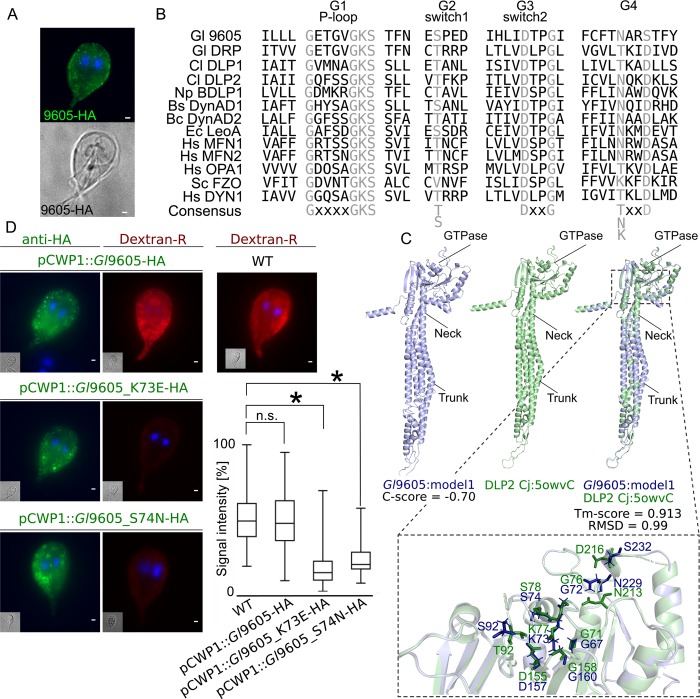
The extended GlPXD3 interactome includes a novel dynamin-like protein in G. lamblia.(A) Light-microscopy-based immunofluorescence analysis of representative transgenic trophozoites expressing epitope-tagged reporter variants (green) for protein Gl9605. Cells were imaged at maximum width, where nuclei and the bare-zone are at maximum diameter. Nuclei are labelled with DAPI (blue). Scale bar: 1 μm (B) MSA analysis G1-P-loop, G2 switch 1, G3 switch 2 and G4 regions of the conserved GTPase domains of Gl9605, GlDRP, Campylobacter jejuni DLP1 (Uniprot accession CJ0411) and DLP2 (CJ0412), Nostoc punctiforme BDLP1 (B2IZD3), Bacillus subtilis DynAD1 (P54159), Bacillus cereus DynAD2 (CUB17917), and Escherichia coli LeoA (E3PN25) bacterial dynamin-like proteins (BDLPs), Homo sapiens MFN1 (Q8IWA4), MFN2 (O95140), OPA1 (O60313) and DYN1 (Q05193), and Saccharomyces cerevisiae Fzo1p (P38297). Conserved positions are highlighted in grey. (C) I-TASSER de novo predicted 3D structure for Gl9605 (blue) and its closest known structural homologue, C. jejuni DLP2 (5owvC; green) indicating the GTPAse, neck and trunk regions that characterize BDLPs. A close-up view of the overlapping structures in the GTPase domains of Gl9605 (blue) and C. jejuni DLP2 (5owvC; green) marked with specific residues important for GTP binding and catalytic activity. (D) Quantitative microscopy-based immunofluorescence analysis of Dextran-R signal in cells expressing either a non-mutated full-length epitope-tagged Gl9605 or mutated Gl9605 K73E and S74N variants. In contrast to non-transgenic wild-type controls and Gl9605-HA expressing cells, expression of Gl9605 K73E and S74N variants inhibited Dextran-TxR uptake in a statistically significant fashion (box-plot). Asterisks indicate statistical significance. n.s.: not significant.